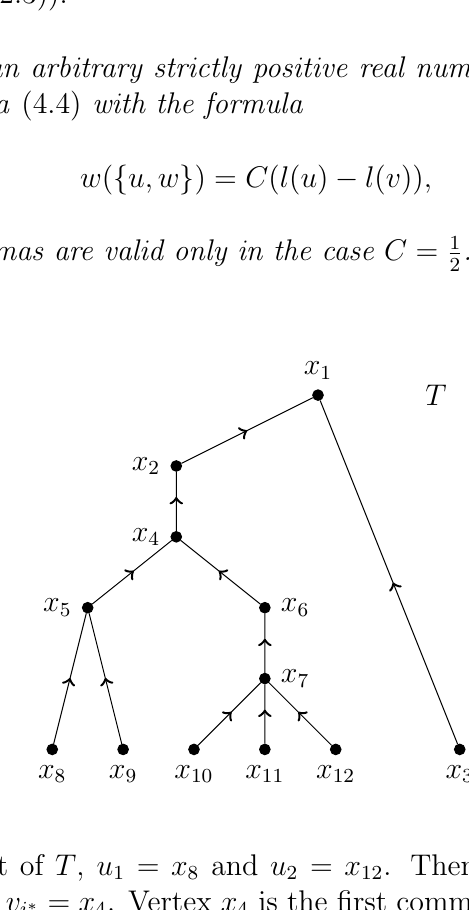
= x and u = x . Then P = ( u 1 8 2 12 = x . Vertex x is the first common vertex of two paths which i ∗ 4 4 1